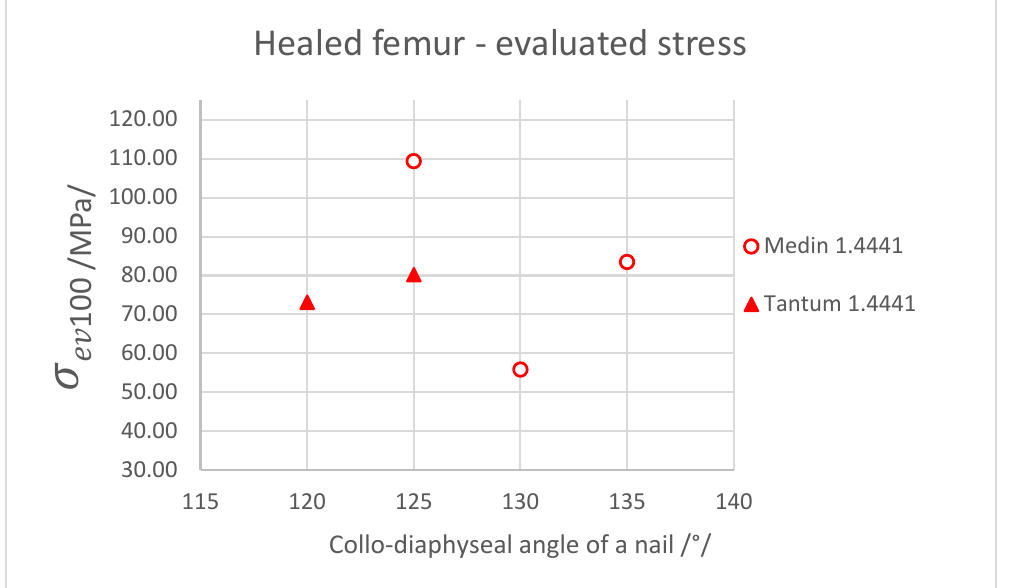
Figure 17. Dependence of evaluated HMH stress (MPa) on nail collo ‐ diaphyseal angle (healed femur).